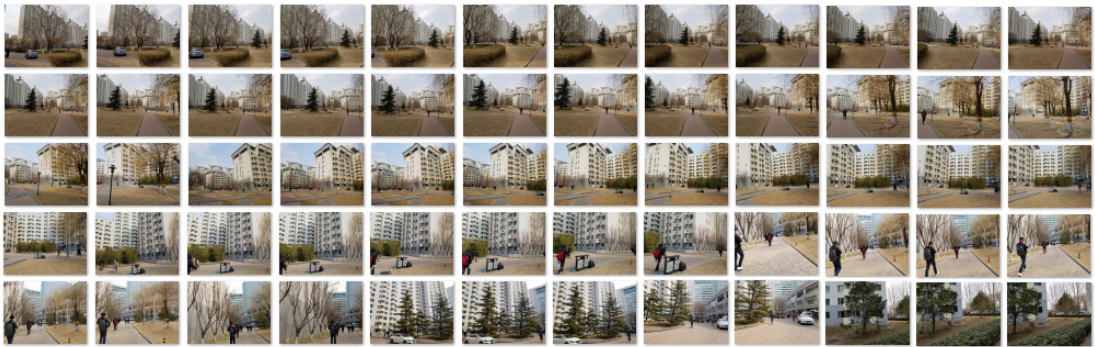
Figure 15. The FPV clip of “Apartment”. This test clip has several “moving forward” and “rotation” movements, and the whole trajectory resembles a “U” shape. This clip was taken by a wearable camera with 1.5 Hz shooting frequency.